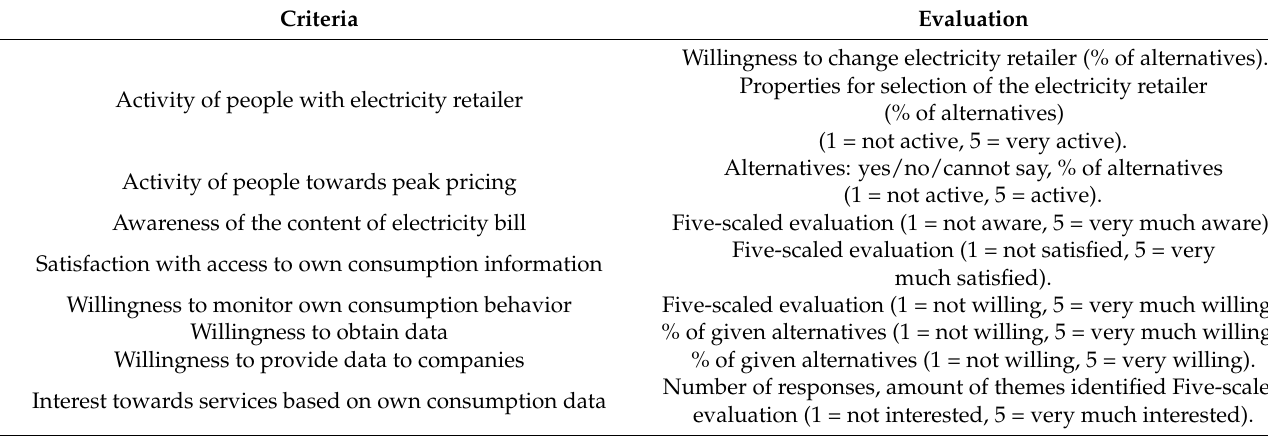
Table 2. Criteria to evaluate the consciousness of residents.